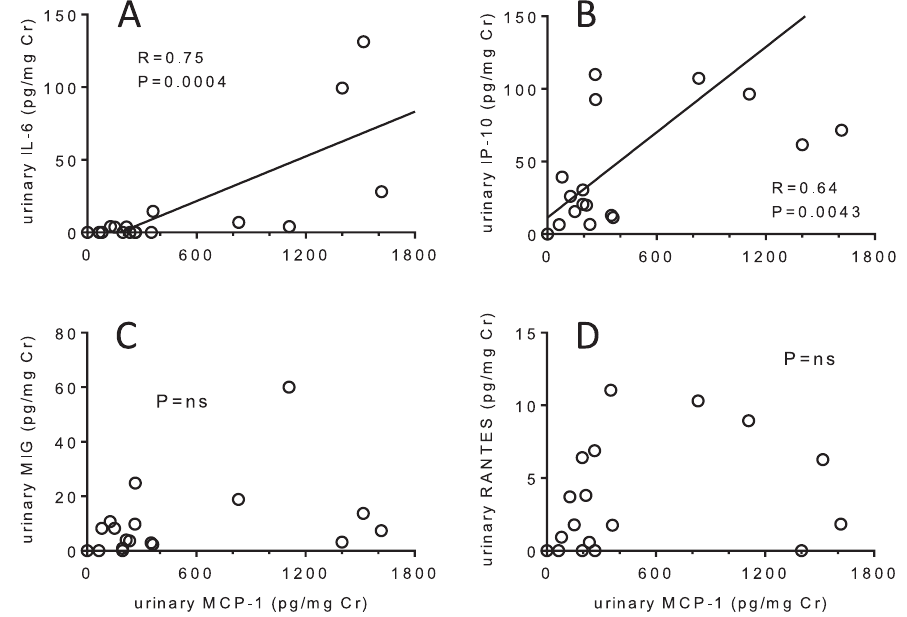
Figure 3 The relationship between urinary MCP-1 and (A) urinary IL-6, IP-10 (B), MIG (C), and